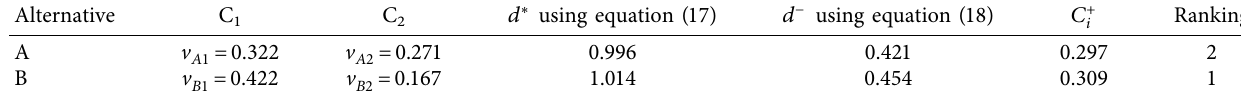
Table 5: Te required calculation based on the revisited